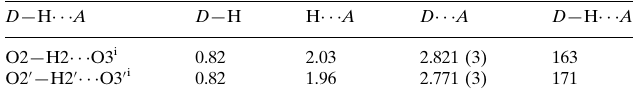
Hydrogen-bond geometry (A˚ , (cid:2)